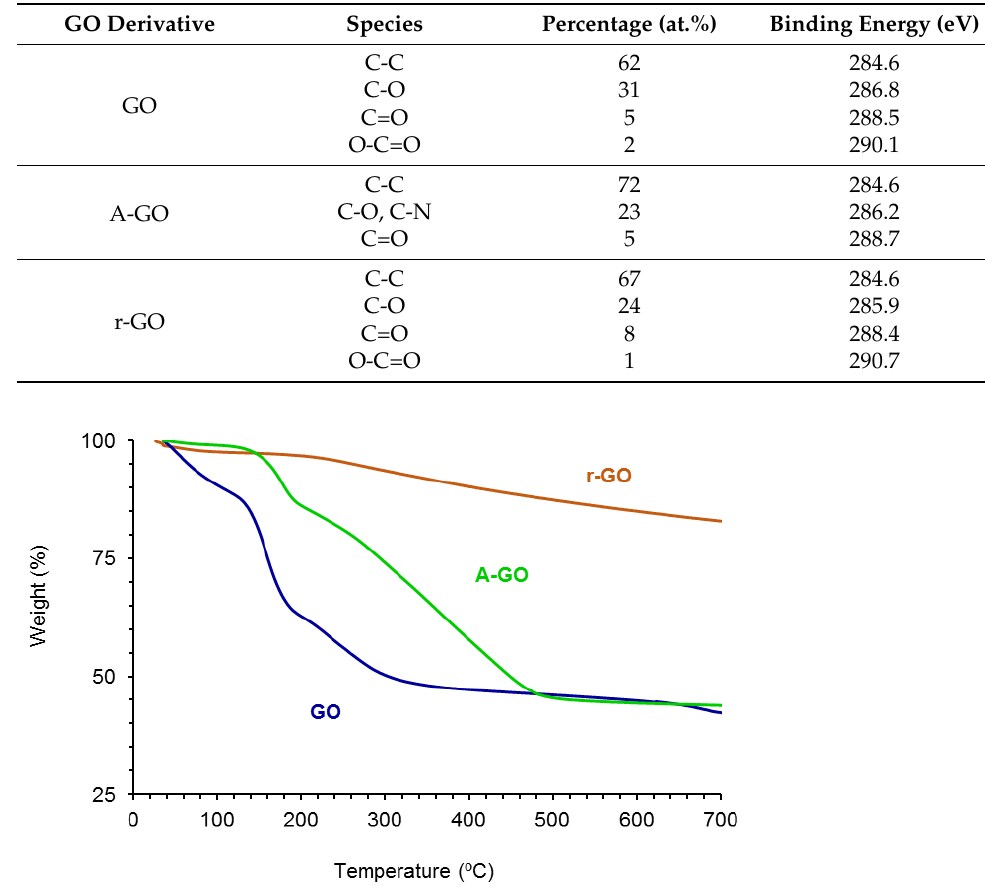
Table 2. Binding energies and percentages of species on the graphene oxide derivative surfaces.